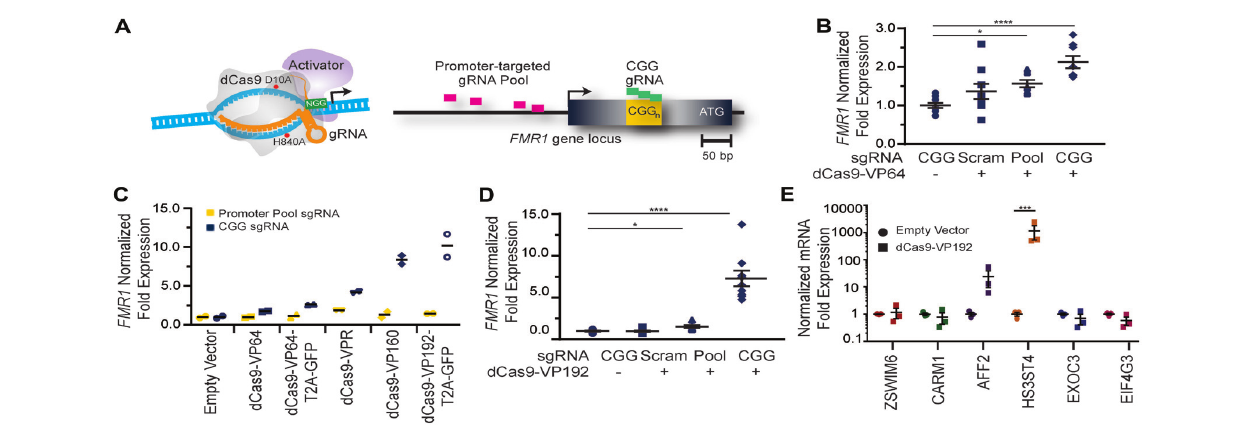
FIGURE 1 | FMR1 messenger RNA (mRNA) increases with Clustered Regularly Interspaced Palindromic Repeat (CRISPR)-mediated targeting of transcriptional activators to either the FMR1 promoter or the CGG repeat. (A) Illustration of nuclease-inactive Cas9 (deficient Cas9, dCas9) fused to a transcriptional activator (left) and guide RNA (gRNAs) targeting regions within the FMR1 promoter or the CGG repeat (right). The promoter-targeted gRNA pool (pink) consisted of four gRNAs with unique targeting sequences, while the CGG gRNA (green) represents a single targeting sequence capable of tiling across the CGG repeat. (B) Relative FMR1 mRNA expression from three independent experiments in HEK293T cells transfected with empty vector or dCas9 fused to VP64 (dCas9-VP64) and non-targeting guide RNA (Scram), a pool of four guide RNAs within the FMR1 promoter (Pool), or a single CGG repeat guide (CGG). (C) Relative FMR1 mRNA expression from a single experiment in HEK293T cells transfected with an empty vector or dCas9 “second generation” activators and the FMR1 promoter gRNAs or the CGG gRNA. (D) Relative FMR1 mRNA expression from three independent experiments in HEK293T cells transfected with a control plasmid or dCas9 fused to VP192 (dCas9-VP192) and the indicated gRNA (for panels B–D , ∗ p < 0.05, ∗∗∗∗ p < 0.0001, Kruskal-Wallis one-way ANOVA with Dunn’s multiple comparison test). (E) Relative expression of select CGG repeat-containing genes after transfection of HEK293T cells with CGG gRNA and dCas9-VP192 constructs ( ∗∗∗ p < 0.001, two-way ANOVA with Sidak’s multiple comparisons test). For all scatter plots shown, each data point represents an individual well and error bars on all graphs represent